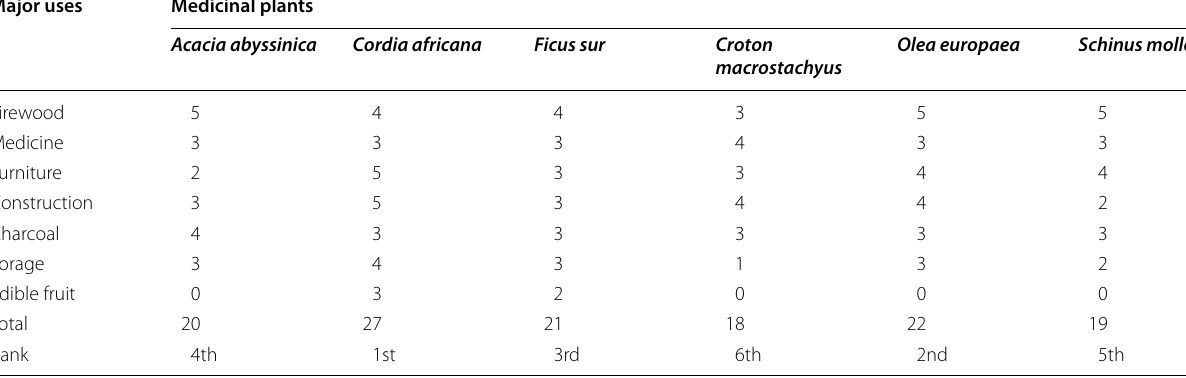
Table 7 Standard score for direct matrix ranking of medicinal plants with use